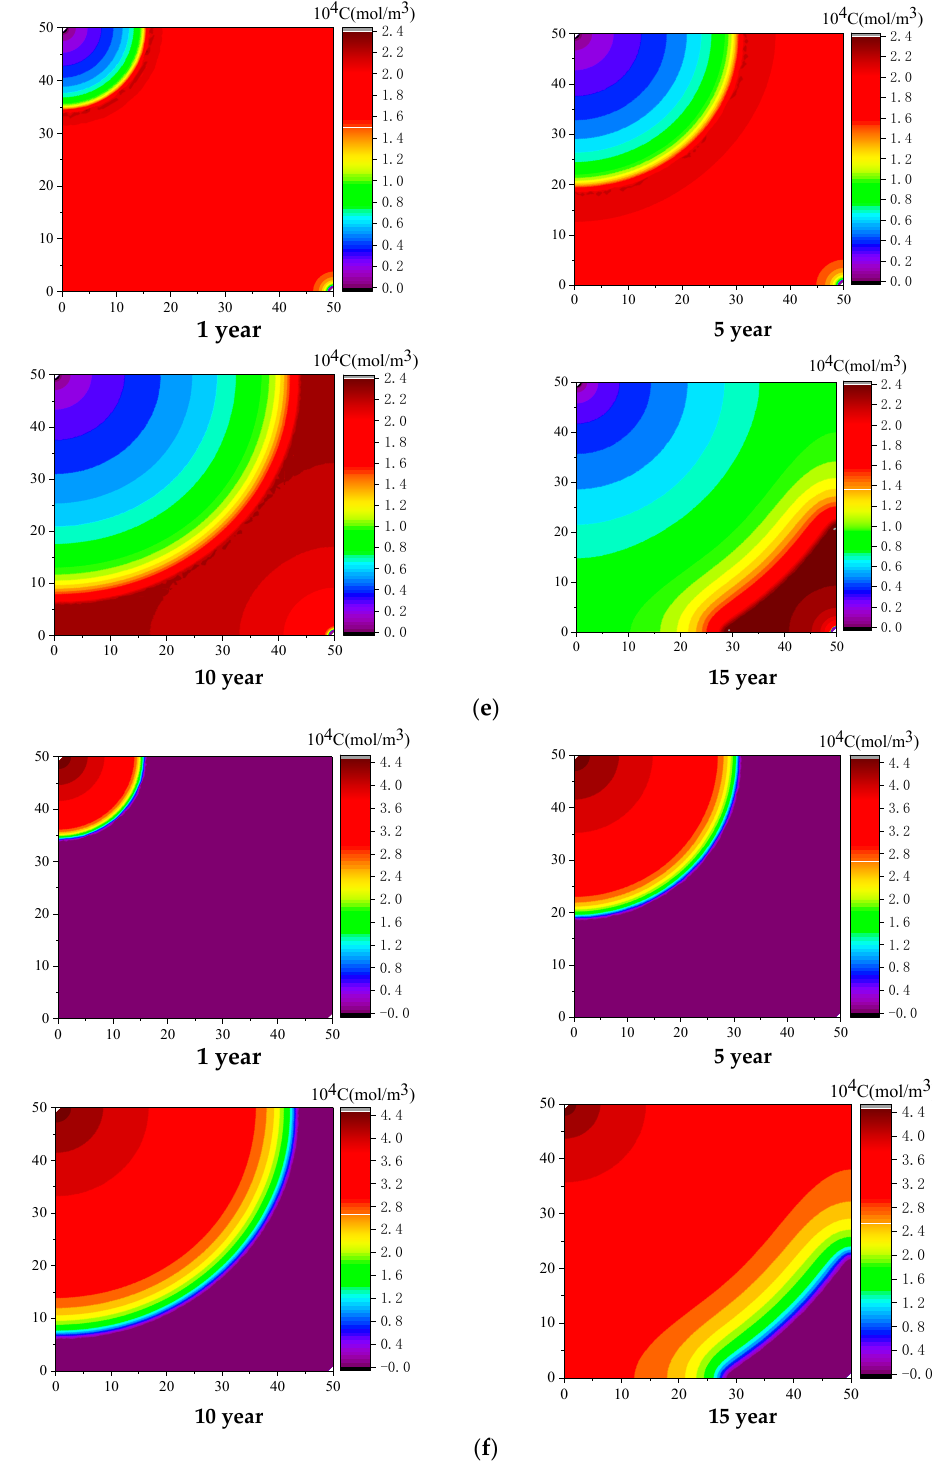
Figure 3. Distribution of CH 4 molar concentration and CO 2 molar concentration under different injection CO 2 pressures: ( a ) distribution of CH 4 molar concentration at 4 MPa injection pressure; ( b ) distribution of CO 2 molar concentration at 4 MPa injection pressure; ( c ) distribution of CH 4 molar concentration at 6 MPa injection pressure; ( d ) distribution of CO 2 molar concentration at 6 MPa injection pressure; ( e ) distribution of CH 4 molar concentration at 8 MPa injection pressure; and ( f ) distribution of CO 2 molar concentration at 8 MPa injection pressure.